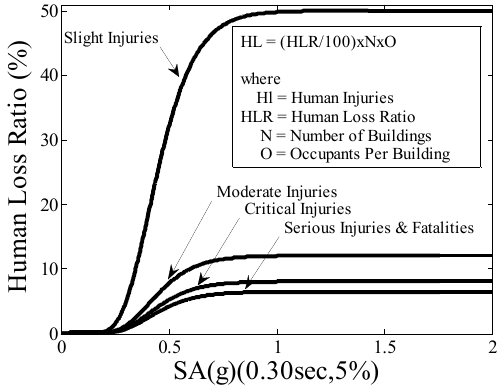
Figure 13 Vulnerability functions for Himalayan Fig. 13. Vulnerability functions for Himalayan DS masonry struc- DS masonry structures obtained using the Spence tures obtained using the Spence (2007b) human consequence (2007b) human consequence factor.